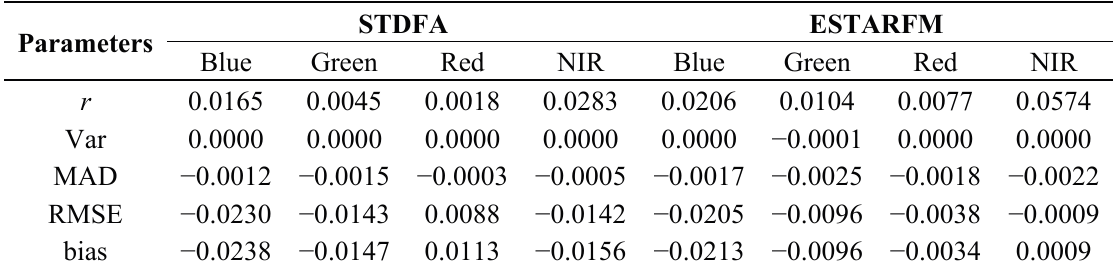
Table 8. Influence of sensor differences on model